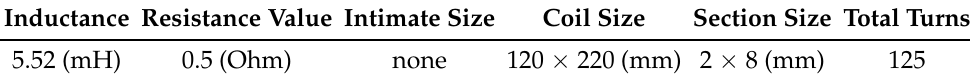
Table 1. The parameters of axial coil.